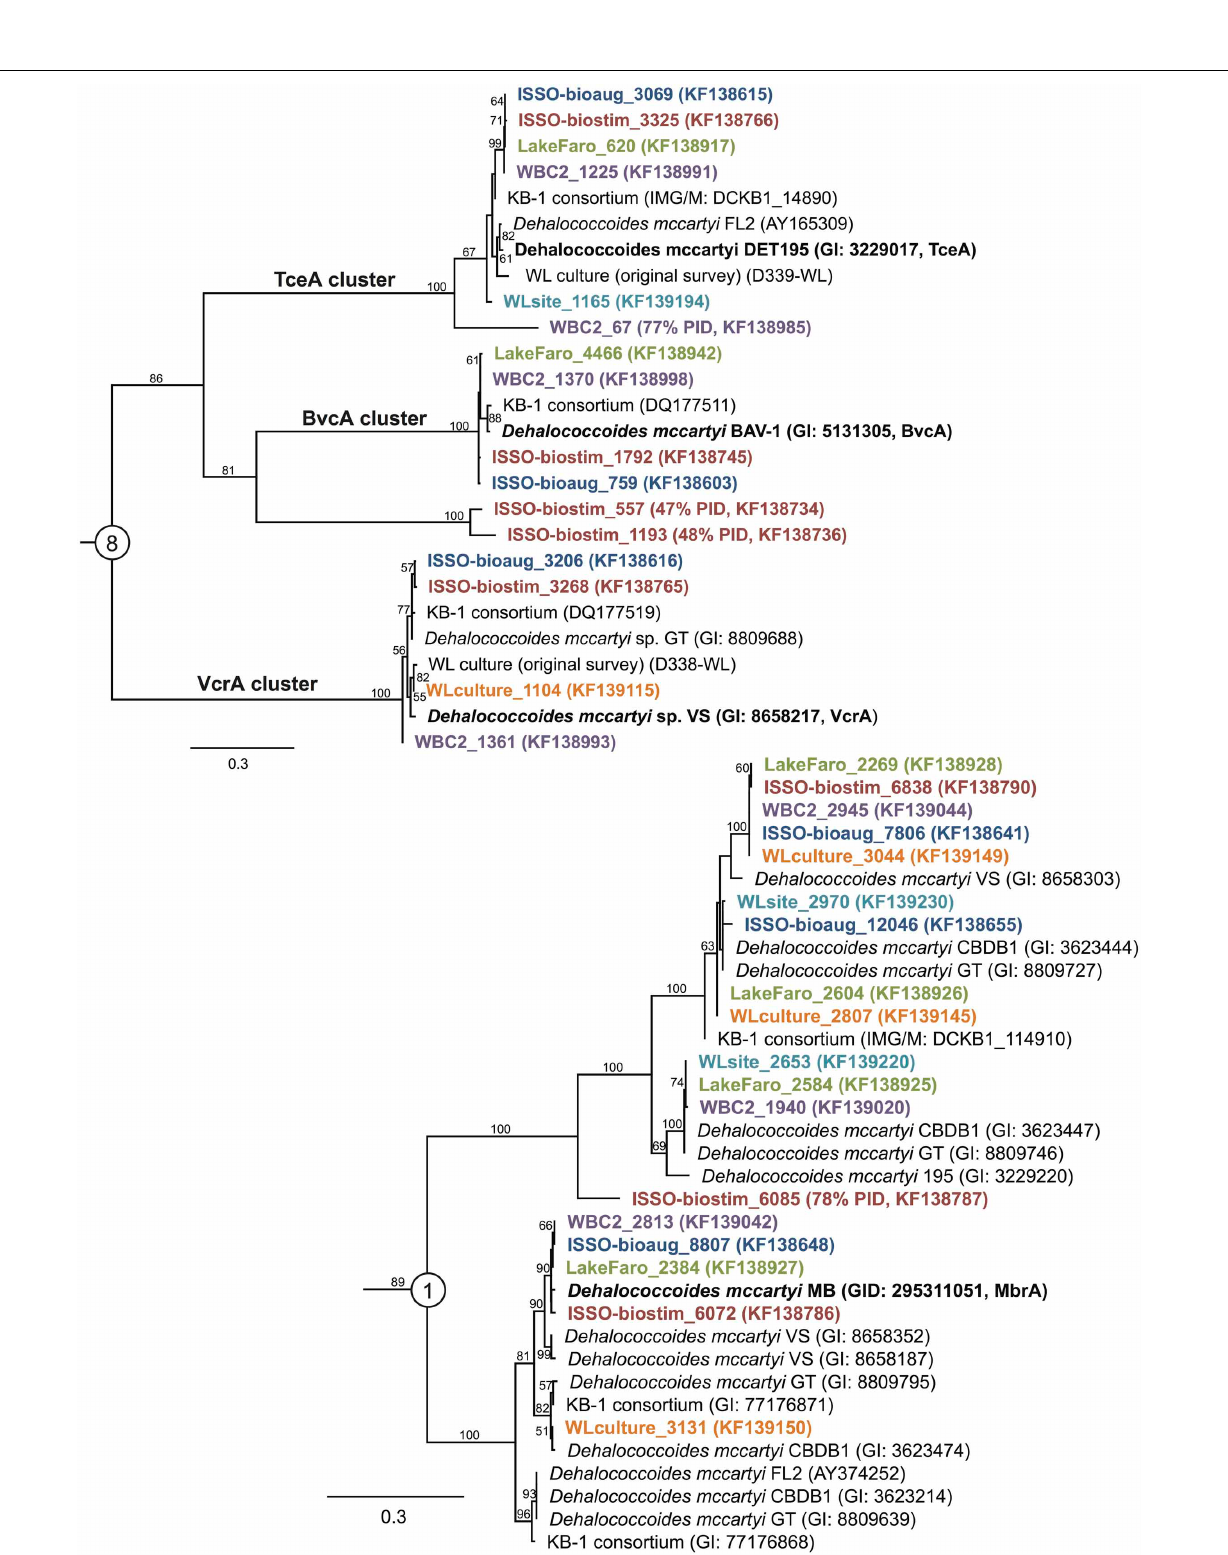
1). The trees were generated in Phyml (Guindon and Gascuel, 2003) under the LG + γ model of amino acid evolution, from a Muscle v. 3.8.31 alignment containing an outgroup sequence (not shown) (Edgar, 2004). Names for newly sequenced RdhA genes correspond to the contig from the idba_ud assemblies (Peng et al., 2012), with NCBI accession numbers in